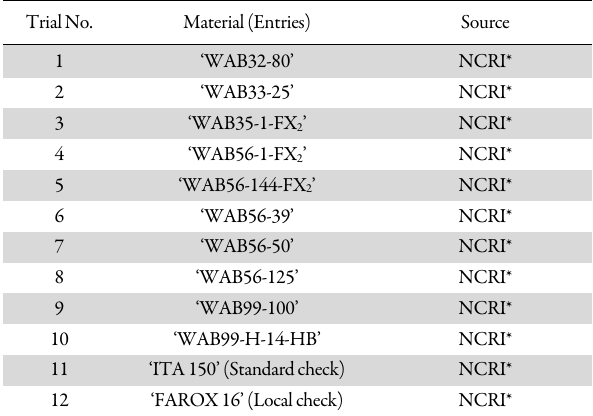
Table 1. List of genotypes used for the study Trial